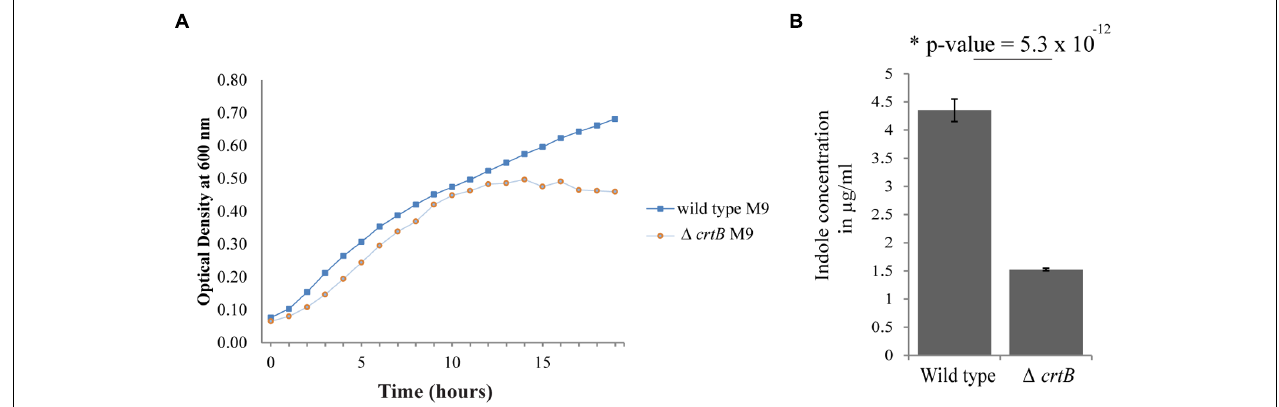
FIGURE 5 | Loss of carotenoids affects growth and phytohormone production. (A) Growth curves of wild type Pantoea sp. YR343 and (cid:49) crtB in M9 minimal medium. (B) Comparison of indole-3-acetic acid production in the wild type Pantoea sp. YR343 and the (cid:49) crtB mutant. The production of indoles was measured using a colorimetric